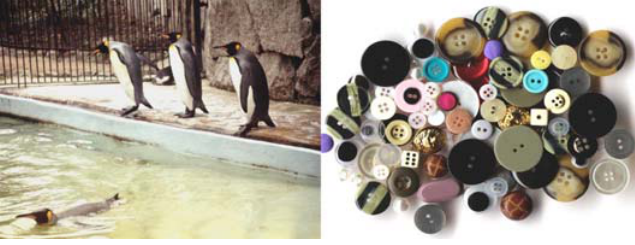
Figure 1: Examples of two of the distinctively individual pictorial stimuli used in the experiments: ‘the penguins’, and ‘the